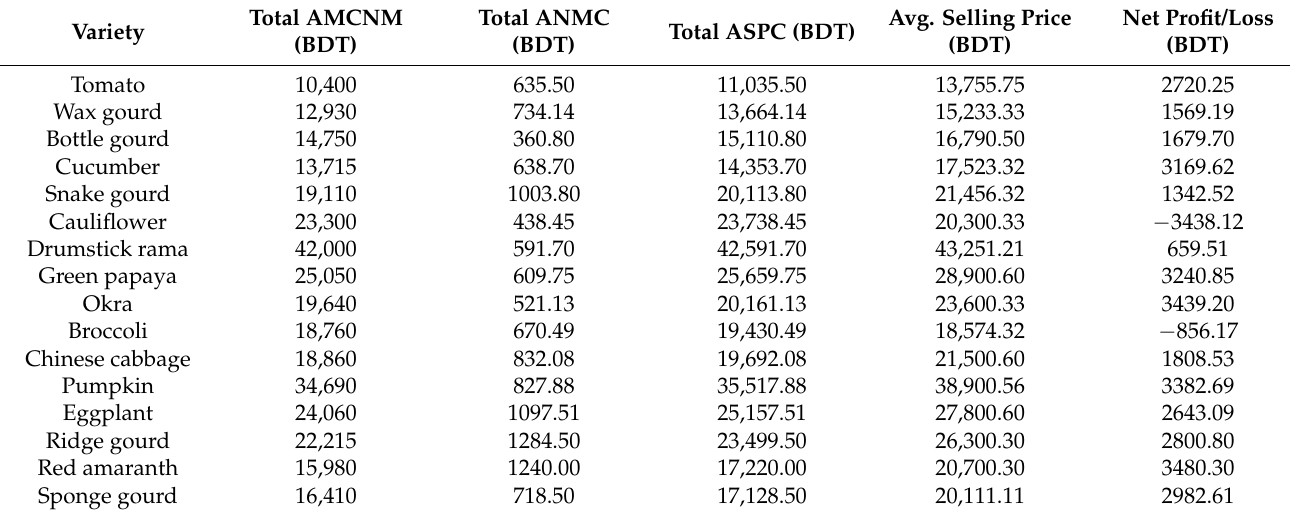
Table 5. Profit or loss calculation of selected vegetable seeds.